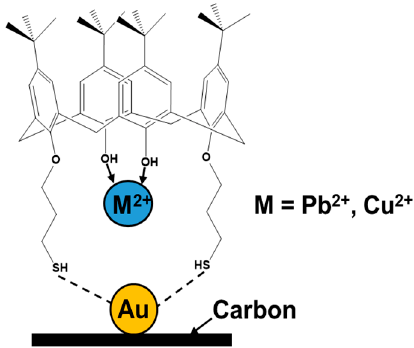
Figure 6. Schematic representation of the binding and complexation mode of TC4/AuNPs/SPCE